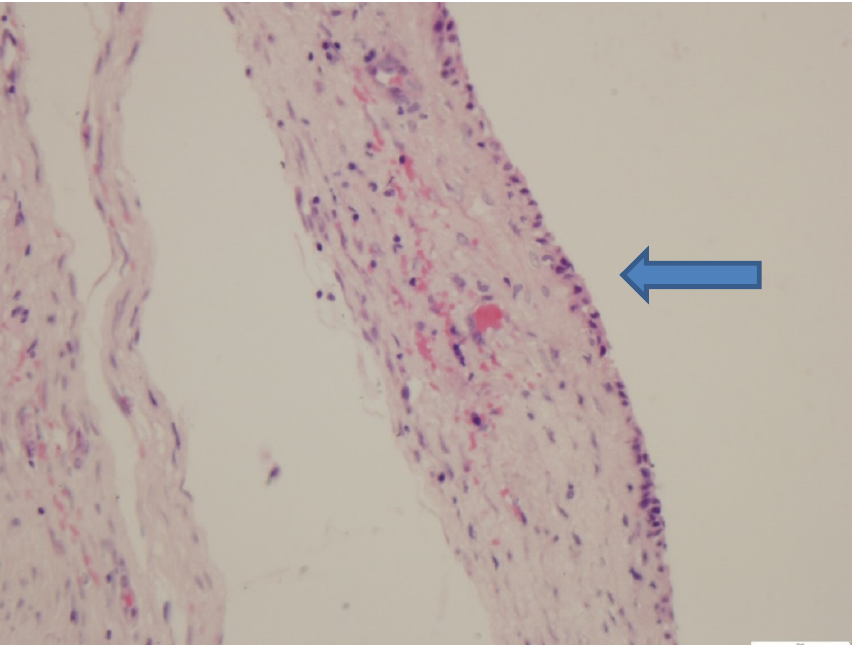
Figure 1. The thick fibrous capsule and the attenuated cuboidal epithelium (arrow). HE stain, 40× magnification.